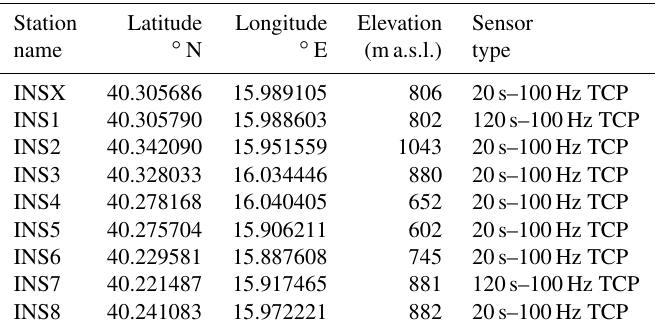
Table 1. Geographic coordinates and elevation of the INSIEME broadband seismic stations with indication of the sensor type installed at each station (TCP: Trillium Compact Posthole).